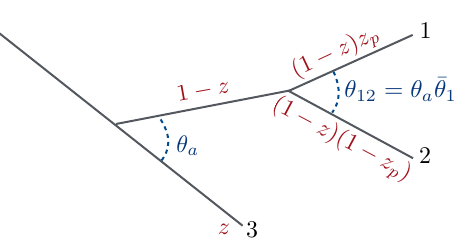
Figure 5. Parametrisation of an i → 123 splitting. After a first i → 3 + a splitting a participates in a further a → 12 splitting with characteristic angle θ that between the parent parton a and the final-state parton 3 . Note that the soft limit corresponds to z → 1 while in all previous sections it was parameterised by z → 0